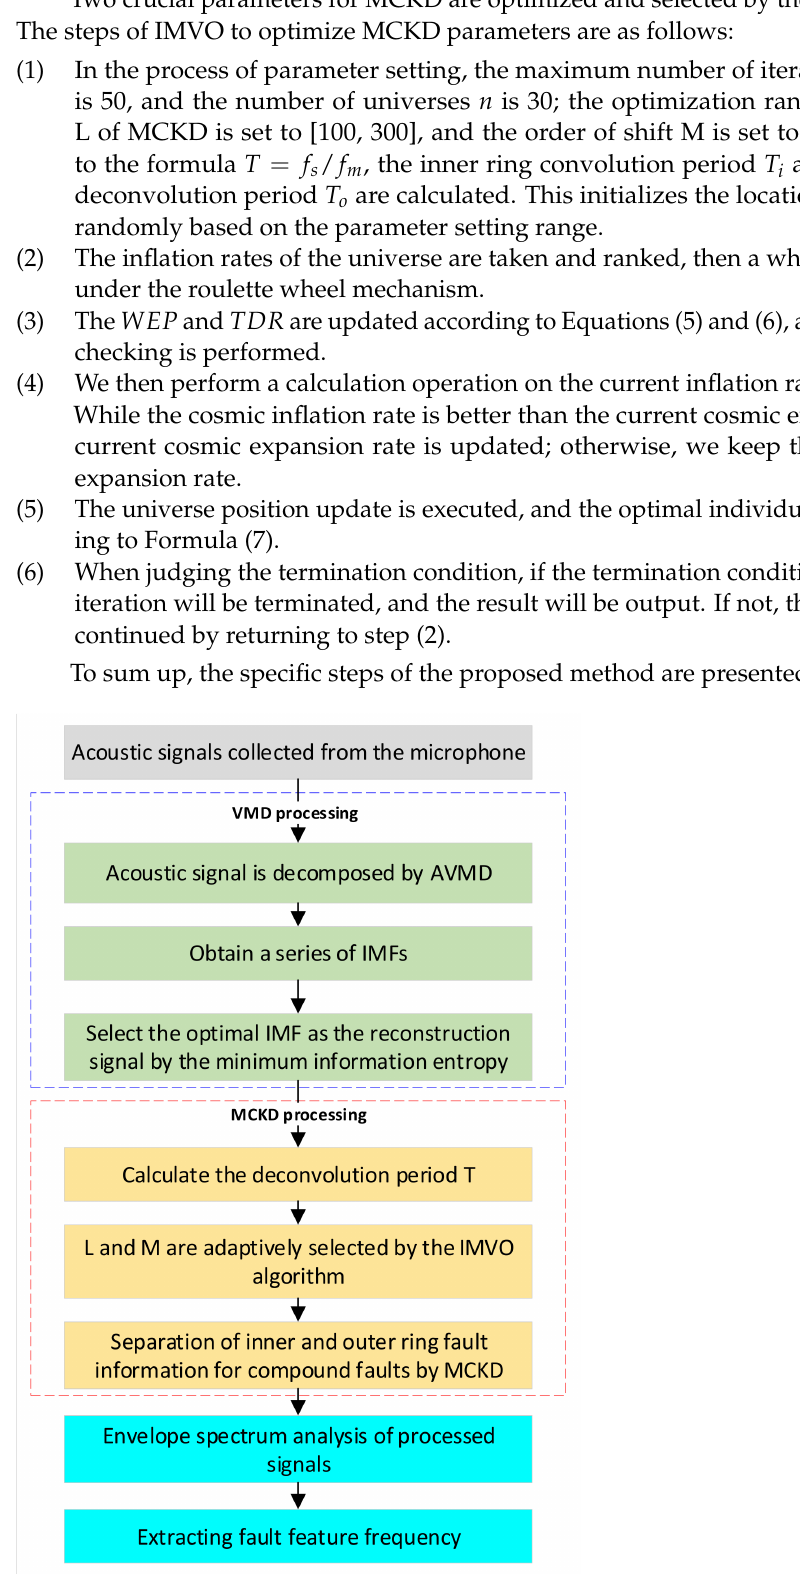
Figure 2. The detailed steps of AVMD-IMVO-MCKD for an acoustic